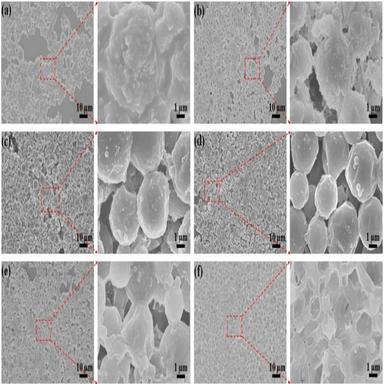
FE-SEM images of MicroPCMs at different pH values of O/W emulsion: (a) pH = 5.5, (b) pH = 6.0, (c) pH = 6.5, (d) pH = 7.0, (e) pH = 8.0 and (f) pH = 9.0.